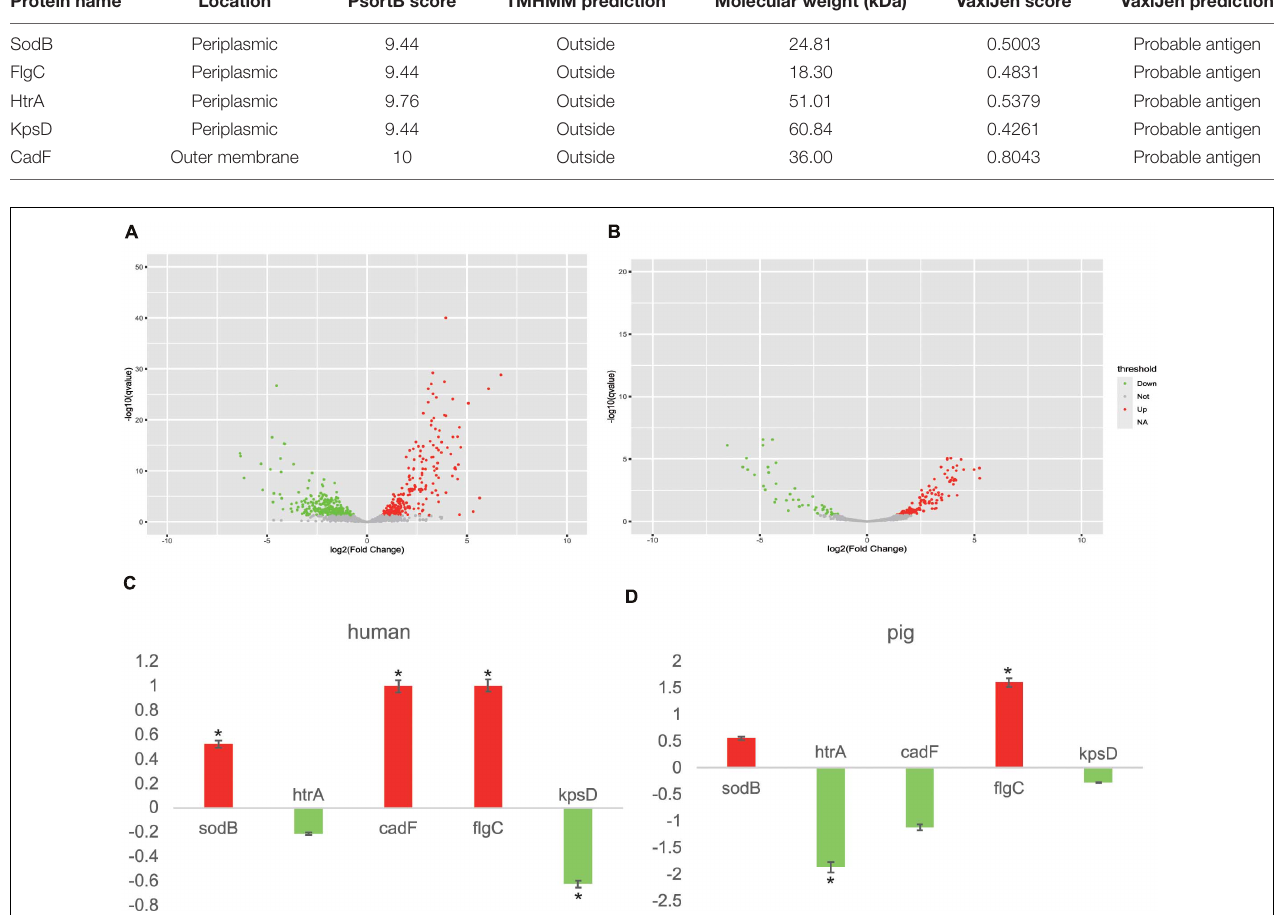
FIGURE 4 | Campylobacter jejuni transcriptome analysis in human INT 407 and Caco-2 cells and the pig intestinal loop. (A) Transcript level changes between Caco-2/INT 407 and Mueller–Hinton broth. Volcano plot diagrams displaying the differentially expressed genes. Upregulated and downregulated genes are in red and green dots , respectively. (B) Volcano plot diagrams of the transcript level changes between the wild type (WT) and CiaD mutation in the pig intestinal loop. (C) Different expressions of five target genes in human. Color corresponds to that in (A) . (D) Different expressions of five target genes in pig. Red represents upregulated genes and green represents downregulated genes, corresponding to that in (B) . * P < 0.05, Fisher’s exact